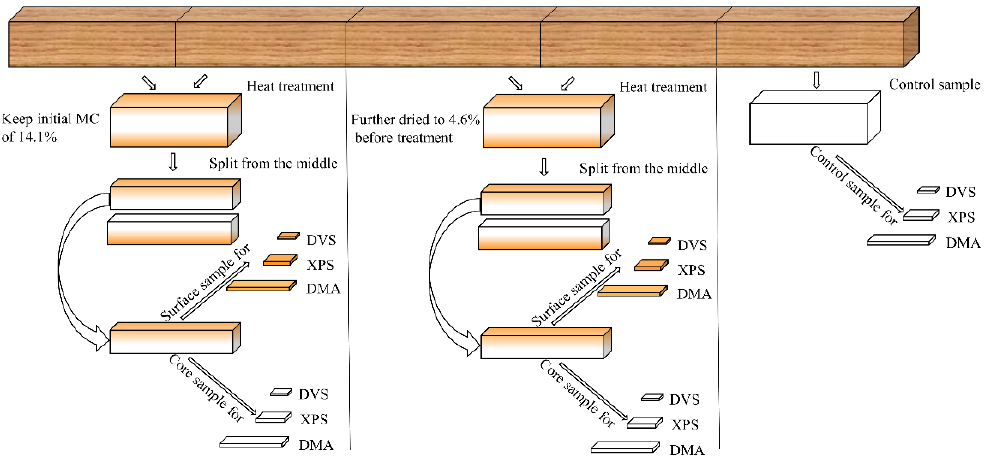
Figure 2. Schematic diagram of sample preparation for heat treatment and instrument analyses.